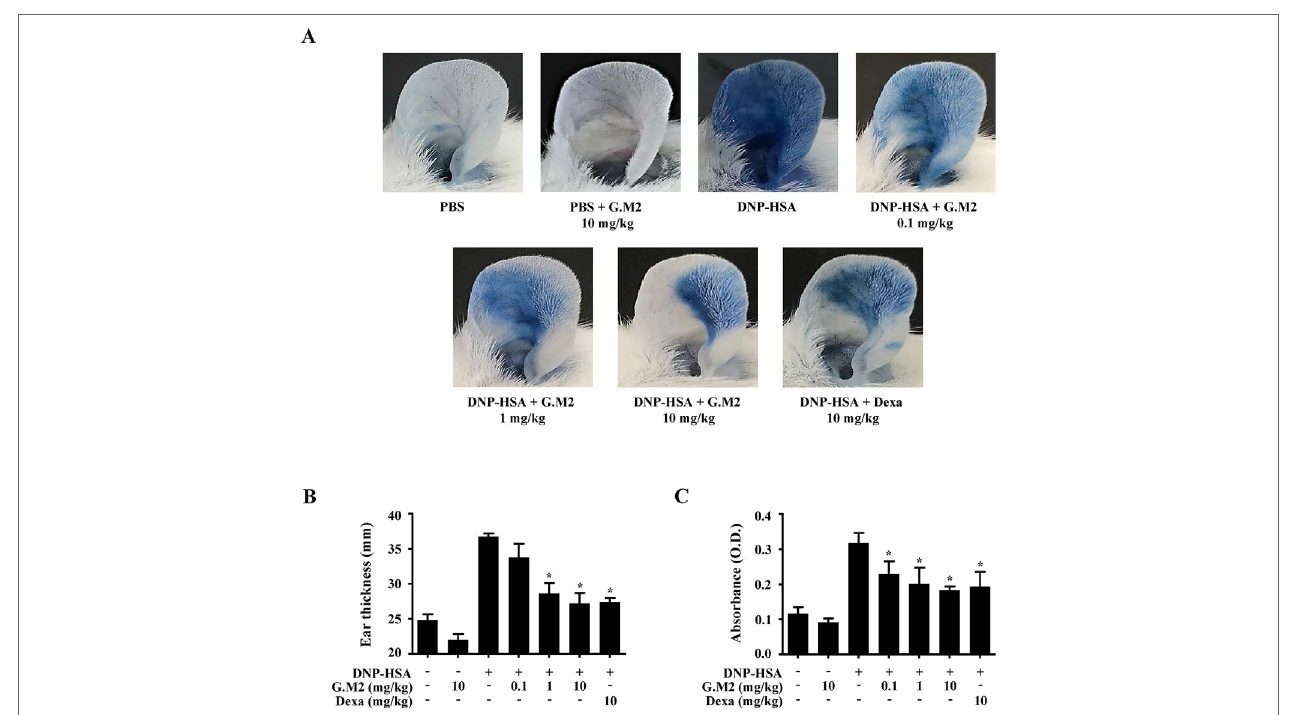
FIGURE 5 | Effects of G.M2 on IgE-mediated passive cutaneous anaphylaxis (PCA). Mouse ear skin (total n = 35, n = 5/group) was sensitized with an intradermal injection of anti-DNP IgE (0.5 μg/site) or PBS for 48 h. G.M2 (0.1–10 mg/kg) and Dexa (10 mg/kg) were administered orally, 1 h before intravenous injection of DNP-HSA (1 mg/mouse) and 4% Evans blue (1:1) mixture. Thirty min later, the thickness of both ears was measured, and the ears were collected to measure pigmentation. Dye extravasation was detected using a spectrophotometer. (A) Representative photographs of ears. (B) Ear thickness. (C) Absorbance representing dye extravasations. Each dataset presented as a graph represents the means ± SEM ( n = 5/group) of two independent experiments. * p < 0.05, compared with the DNP-HSA-challenged group. Dexa, dexamethasone.